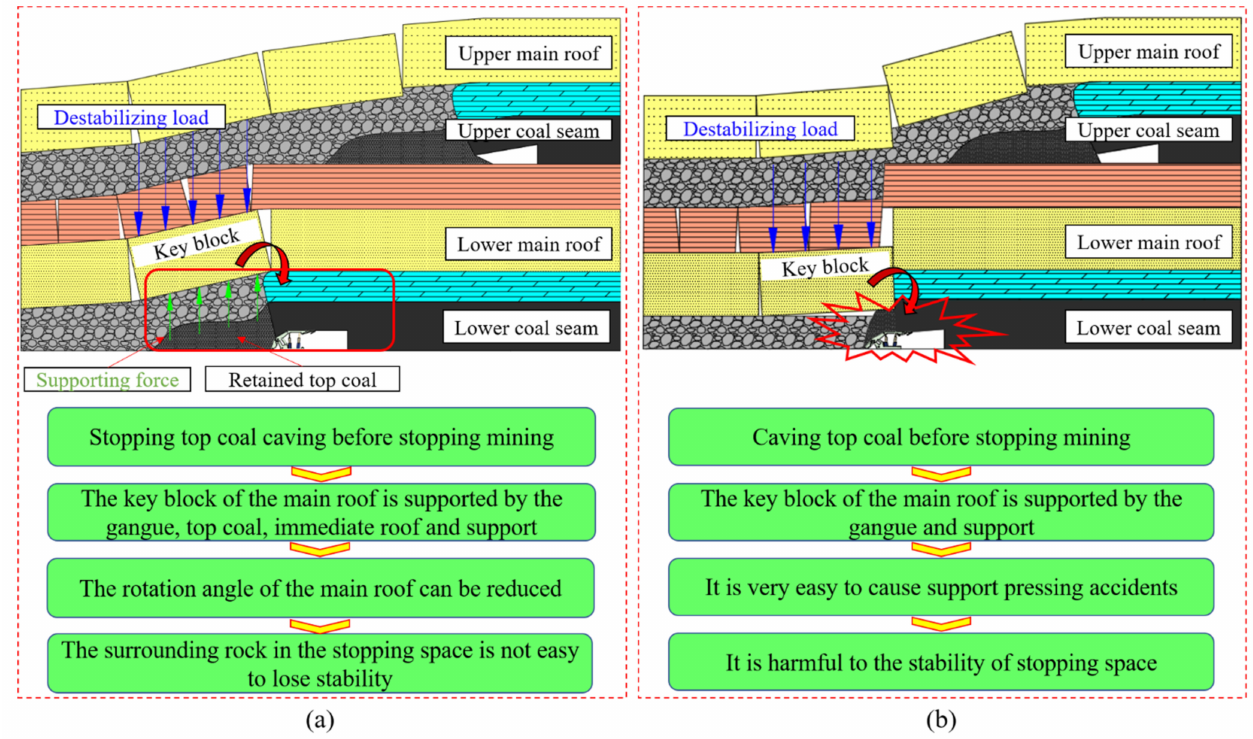
Figure 4. Schematic diagram of no top coal caving and top coal caving before stopping mining. ( a ) No top coal caving before stopping mining. ( b ) Top coal caving before stopping